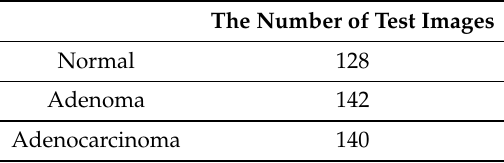
Table 2. Configuration of our test